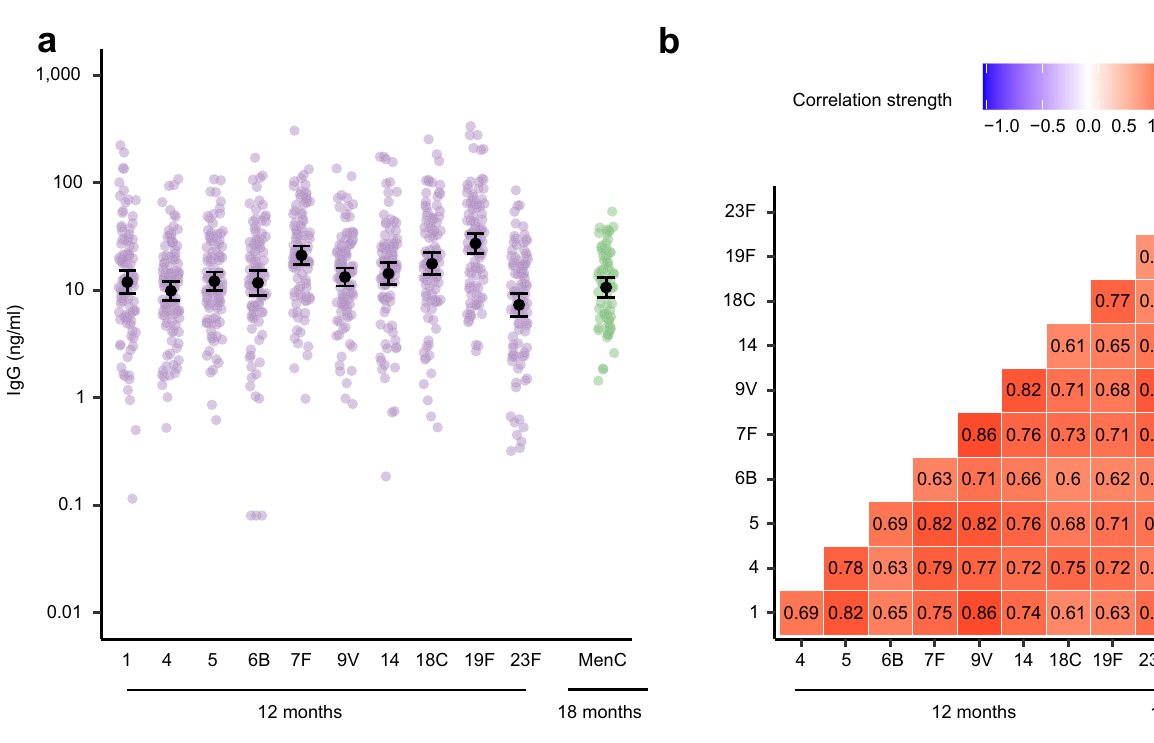
b Correlation plot of IgG concentrations against the 10 pneumococcal vaccine serotypes and against MenC following vaccination. Numbers indicate the correla- tion strength, which wasevaluatedusing Pearson ’ s correlation coef fi cients.Source data are provided in the Source Data fi